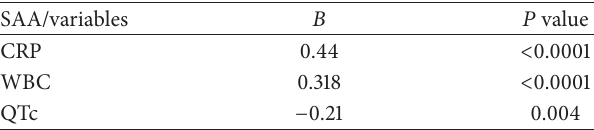
Table 3: Multiple linear regression analysis of associations between SAA concentration and laboratory as well as ECG parameters.